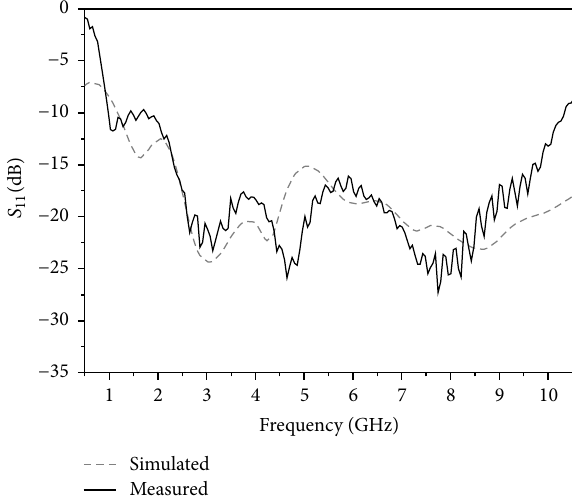
Figure 6: Simulated return loss of proposed antenna at height of air substrate.